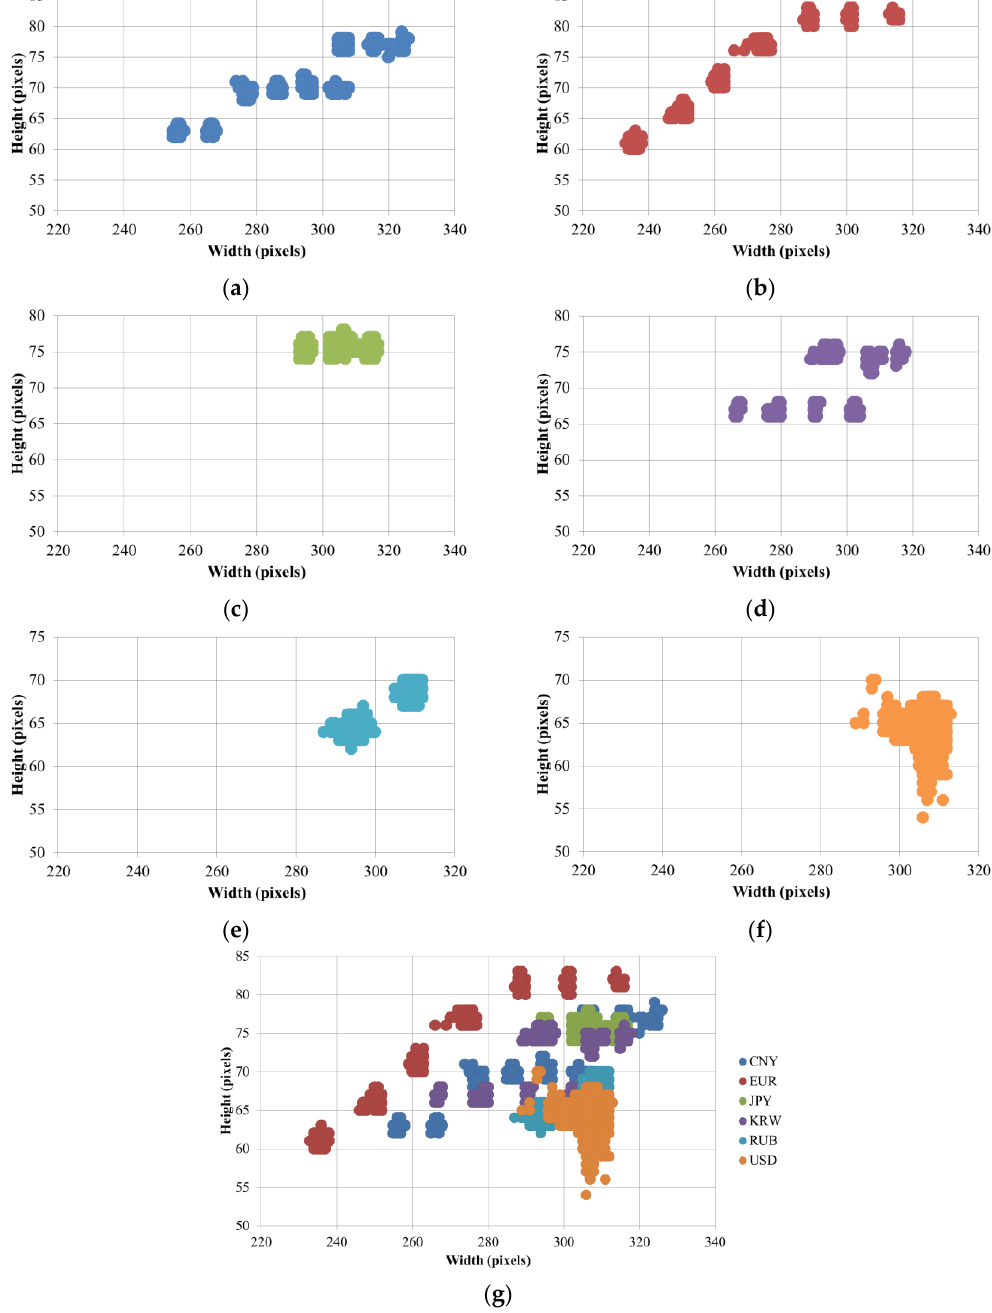
Figure 4. Banknote size distribution of: ( a ) CNY; ( b ) EUR; ( c ) JPY; ( d ) KRW; ( e ) RUB; ( f ) USD; and ( g ) all the above national currency papers.